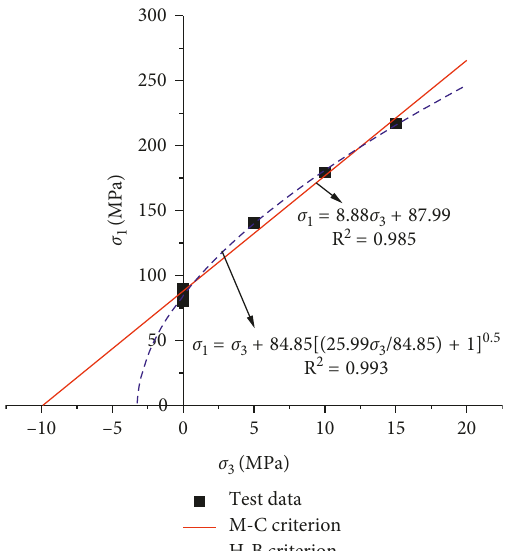
Figure 3: Peak strength analysis of the sandstone samples undergoing uniaxial and triaxial compression. The scatter points are test results; the red line represents the theoretical values in accordance with the M-C criterion; and the blue line represents the theoretical values calculated by the H-B